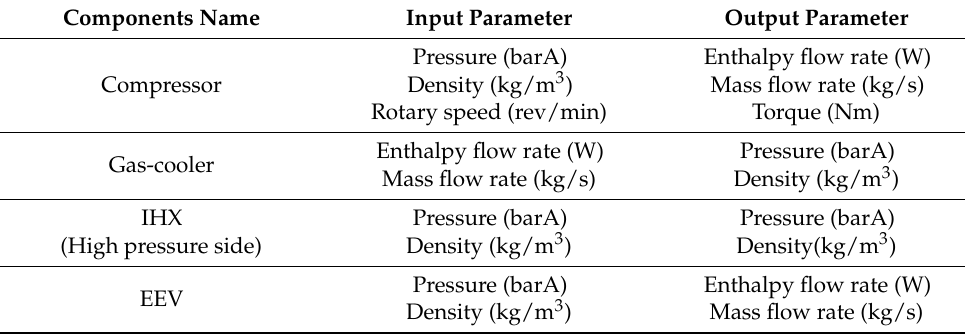
Table 2. Parameters used in the